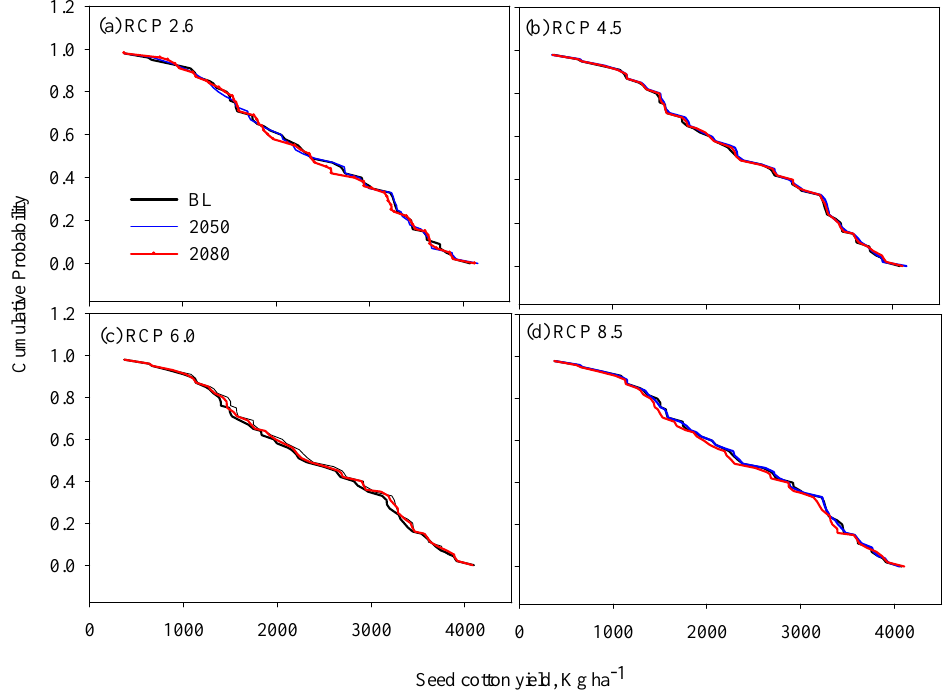
Figure 12. Simulated impacts of rainfall changes alone in 2050 and 2080 on rainfed seed cotton yield for RCP 2.6 ( a ), 4.5 ( b ), 6.0 ( c ), and 8.5 ( d ) emission scenarios on rainfed seed cotton yield. Projected changes in both maximum and minimum temperatures and CO 2 and rainfall changes were not included.